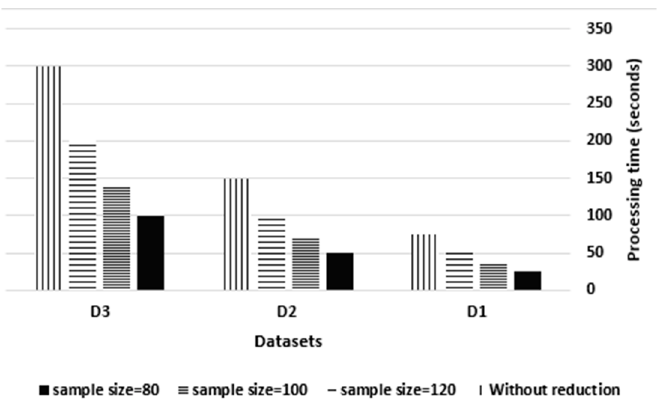
Figure 10. STDF processing time vs. the sample size.